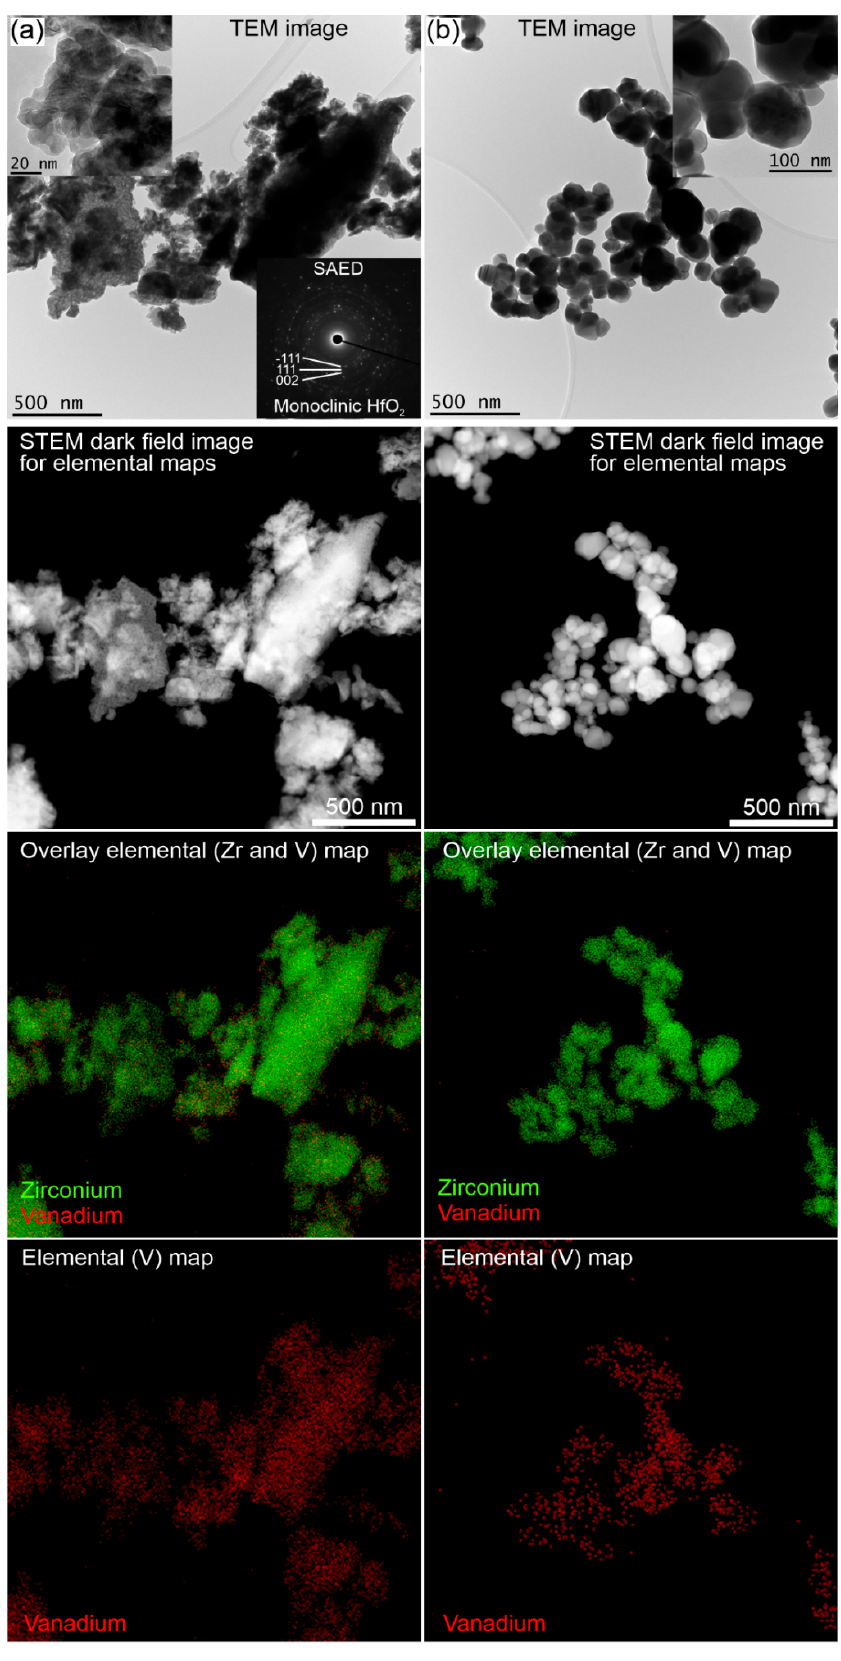
Figure 3. Analytical (S)TEM analysis of VHf catalysts. ( a ) 3VHf SG and ( b ) 2VHf Imp.